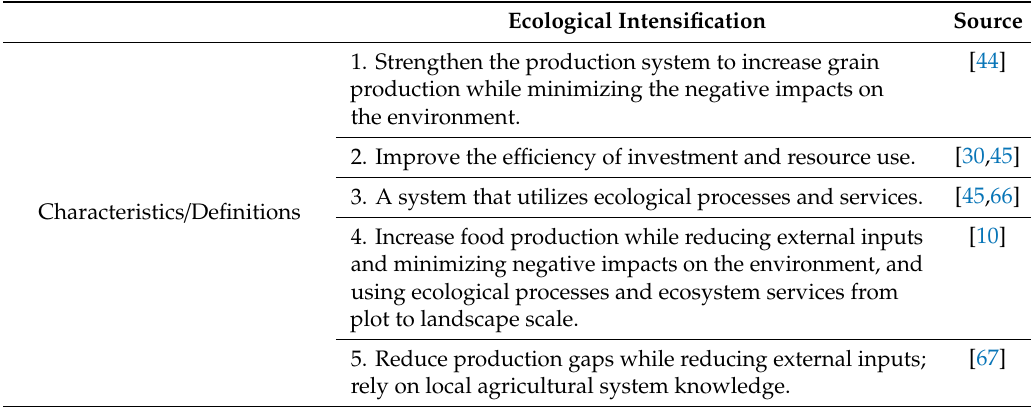
Table 2. Key characteristics / definitions of ecological